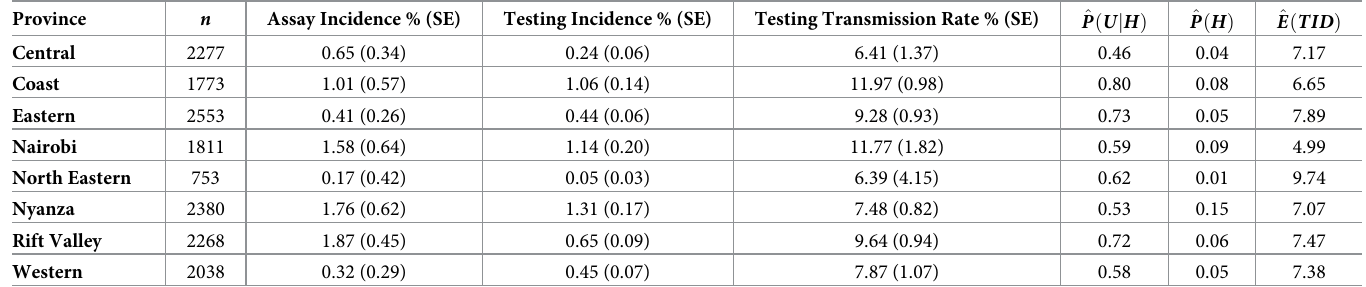
Table 2. Incidence results for KAIS 2007 by province.